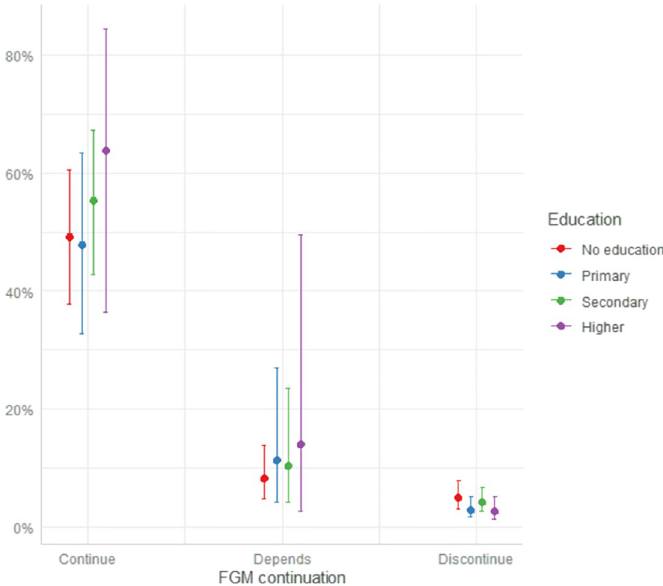
Fig 1. Predicted probabilities of circumcision among youngest daughters by mother’s education and attitude to FGM/C continuation.